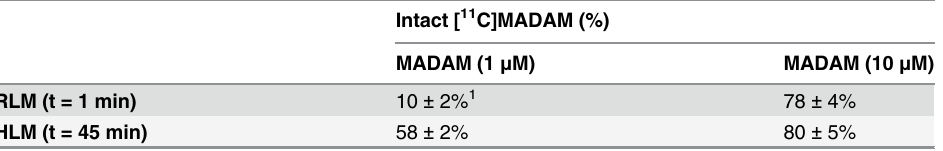
Table 2. Percentages of unchanged [ 11 C]MADAM after incubation with rat (RLM) or human (HLM) liver microsomes in the presence of carrier at two different